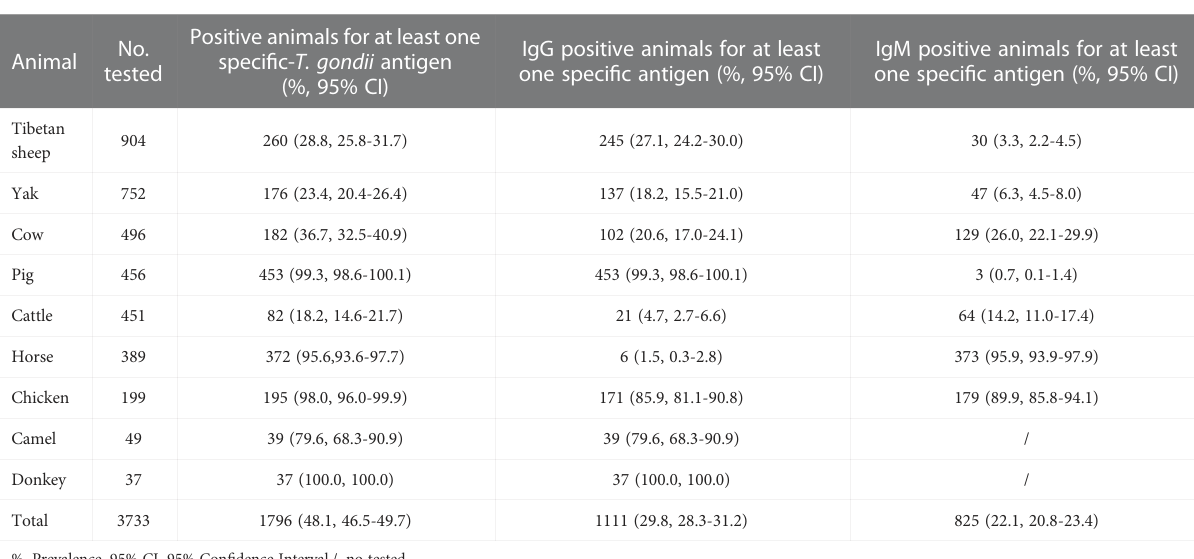
TABLE 5 Animals with seropositive for at least one speci fi c- T. gondii antigen in animals.